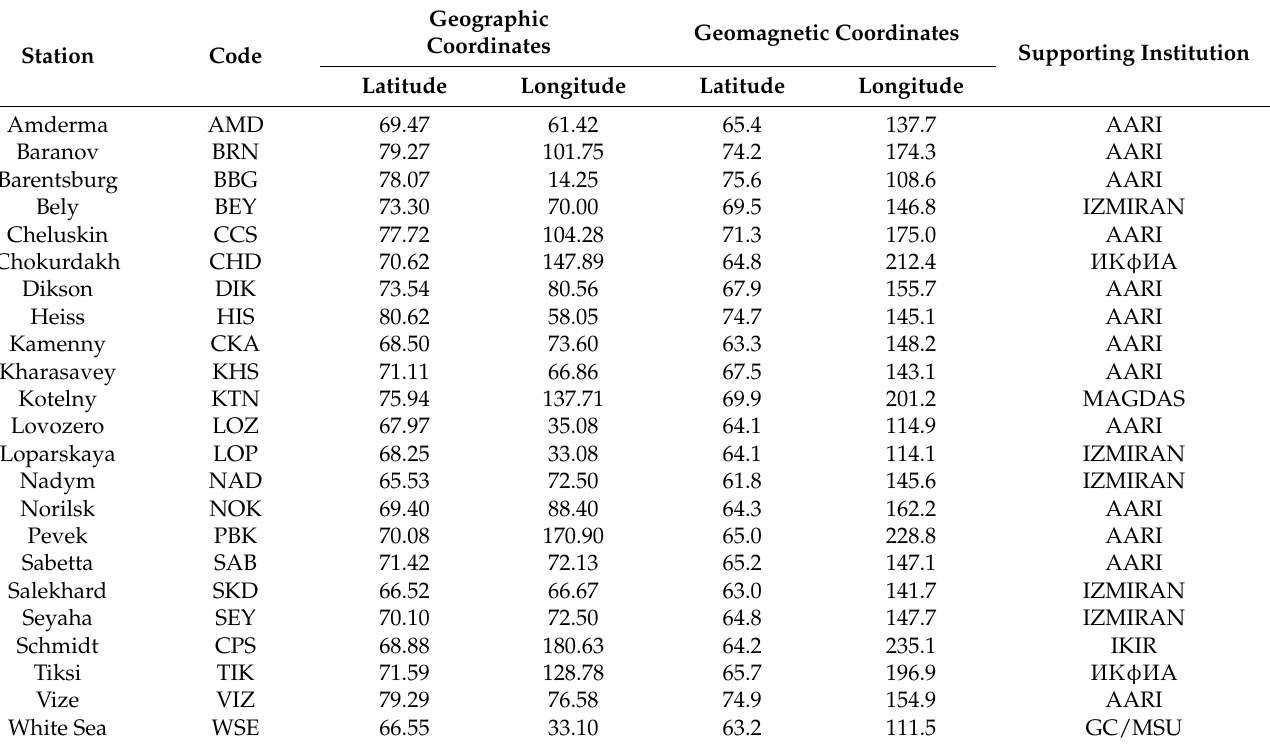
Table 1. Geographic and corrected geomagnetic coordinates of stations in the Russian Arctic for the epoch